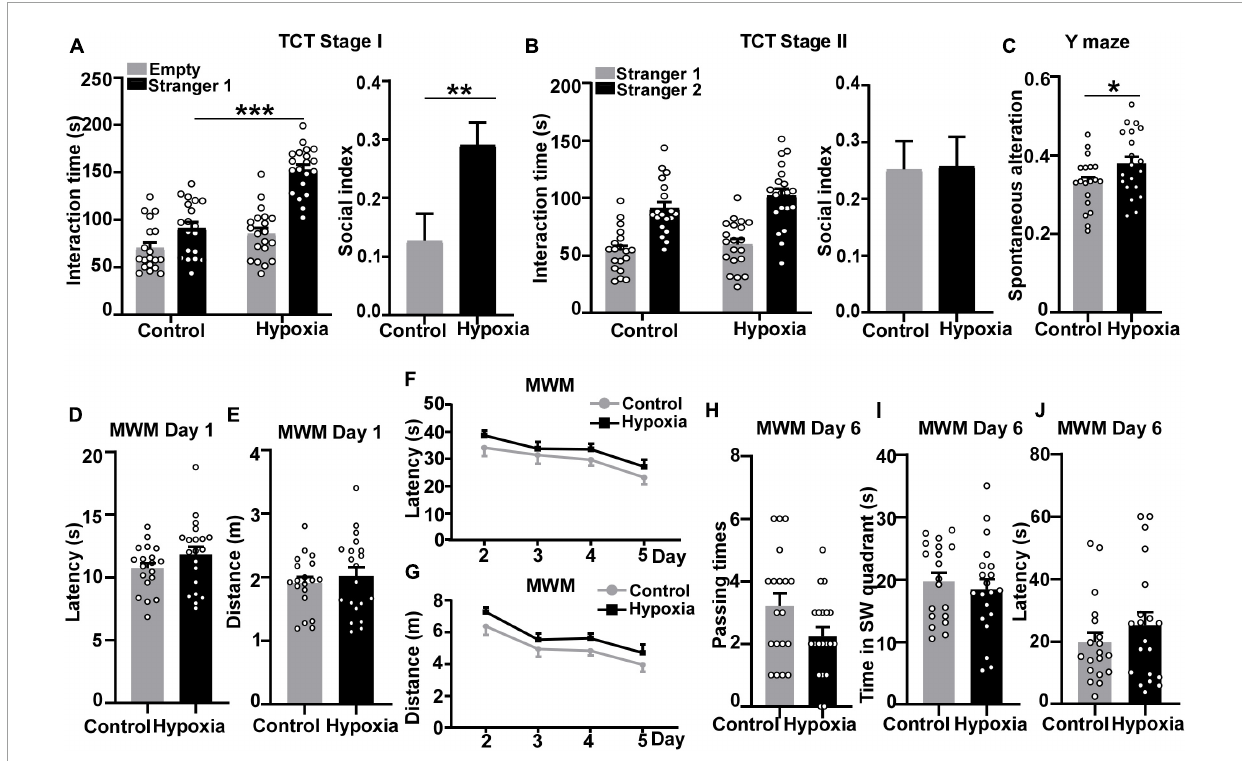
FIGURE1 Intermittent hypoxia treatment enhanced sociability and working memory in mice. 1-month-old C57BL/6J mice were treated with 8% O 2 , 16 h/day for 2 weeks, followed by behavior tests at 6 weeks old. Three-chamber social approach test was performed to detect the impact of hypoxia